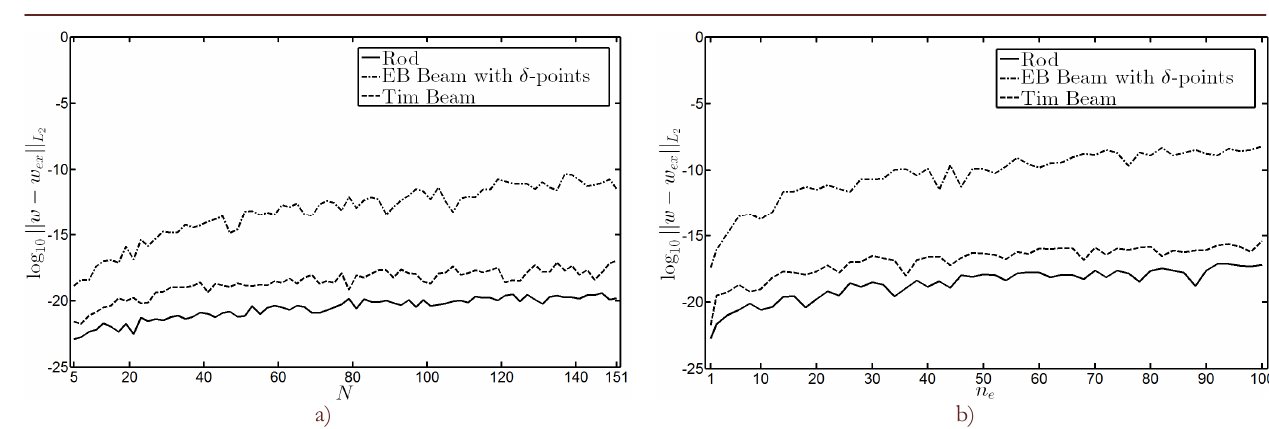
Figure 1: a) Static analysis for single element structural components varying the number of points N for a CC Rod, SS EB beam with  -points (1/2) and a CC Tim beam using PDQ basis functions and Che-Gau-Lob grid distribution. b) Static analysis for structural n with 7 N  for a CC Rod, SS EB beam with  -points (1/2) and a CC Tim beam components varying the number of elements e using PDQ basis functions and Che-Gau-Lob grid distribution.